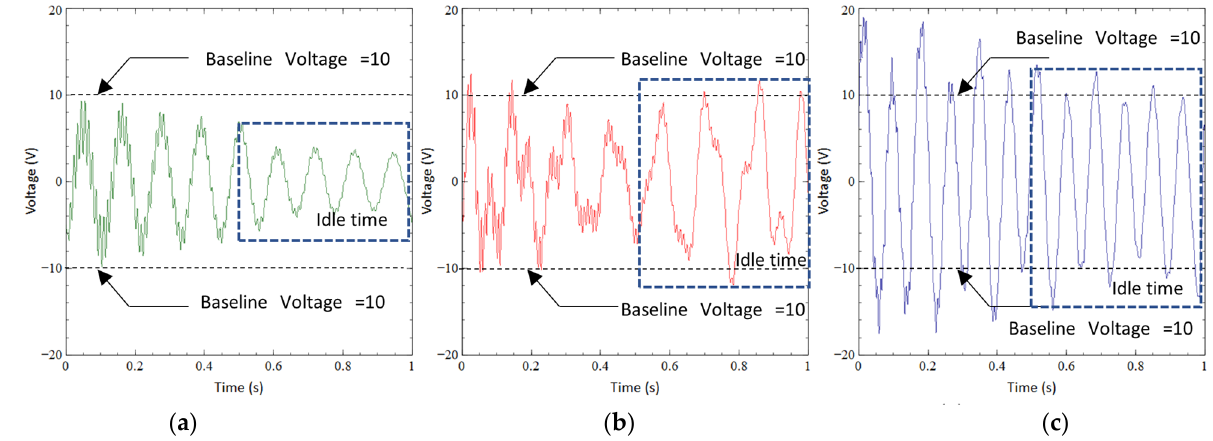
Figure 8. Idle time for ( a ) CBH, ( b ) VBH, and ( c ) BBBH at 1 Hz under 1 g